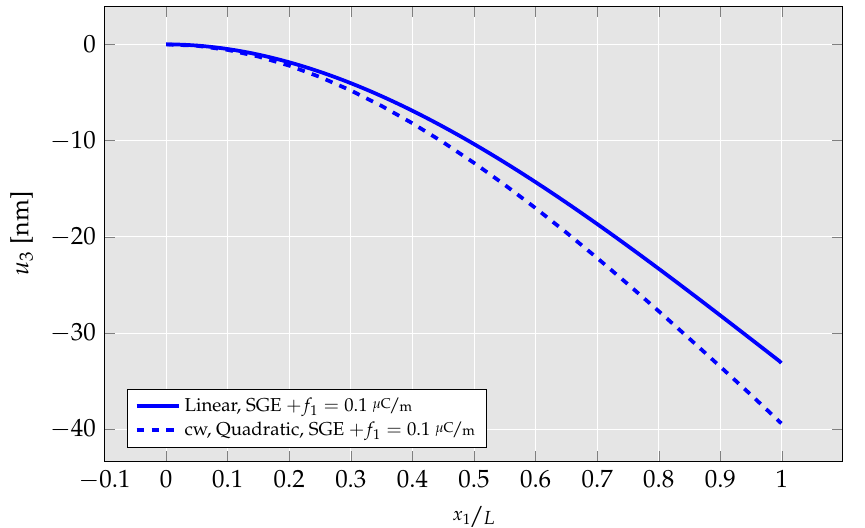
Figure 13. Comparison of deflection calculated by using linear and quadratic element along the length of the